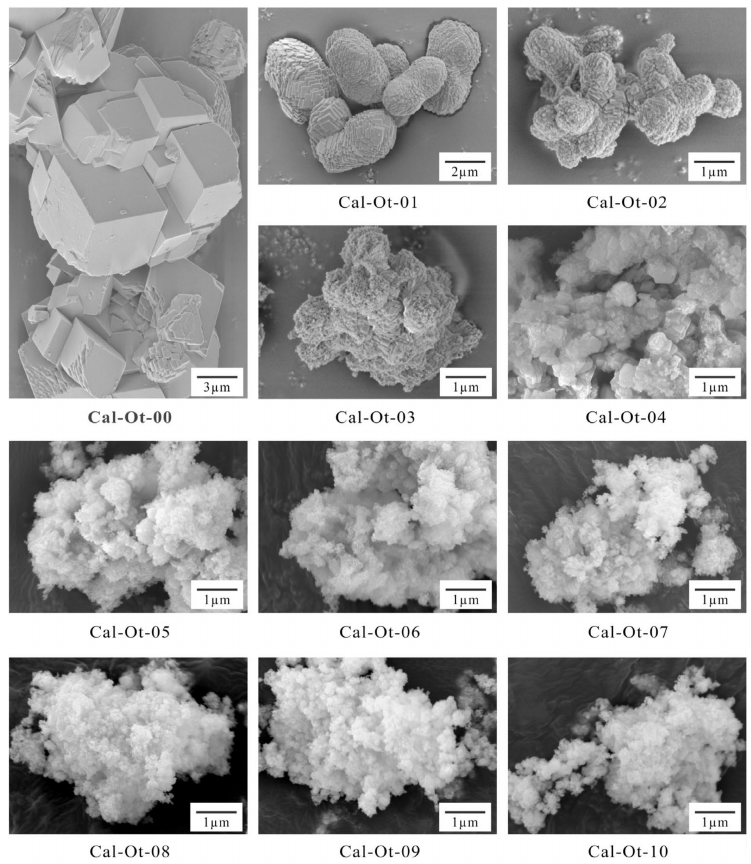
Figure 2. SEM images of the (Ca 1 − x Cd x )CO 3 solid solutions before